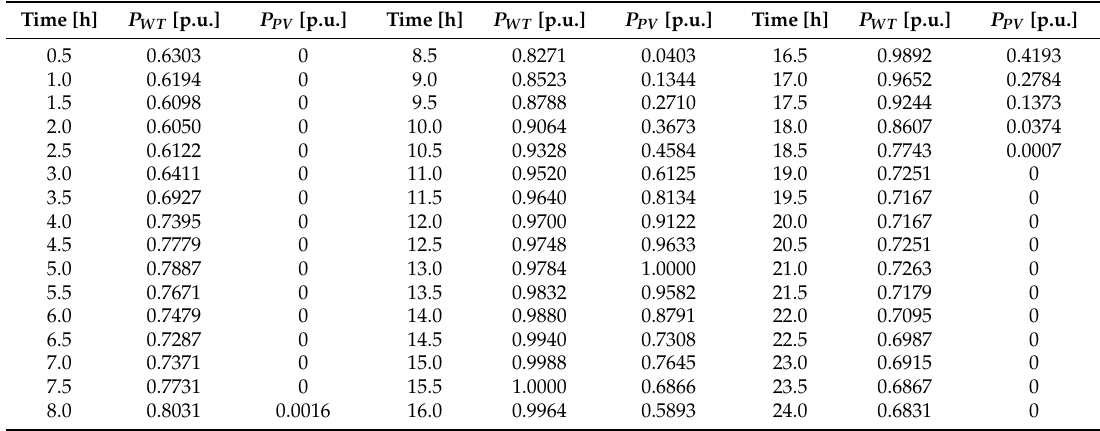
Table 5. Normalized power generation curve.